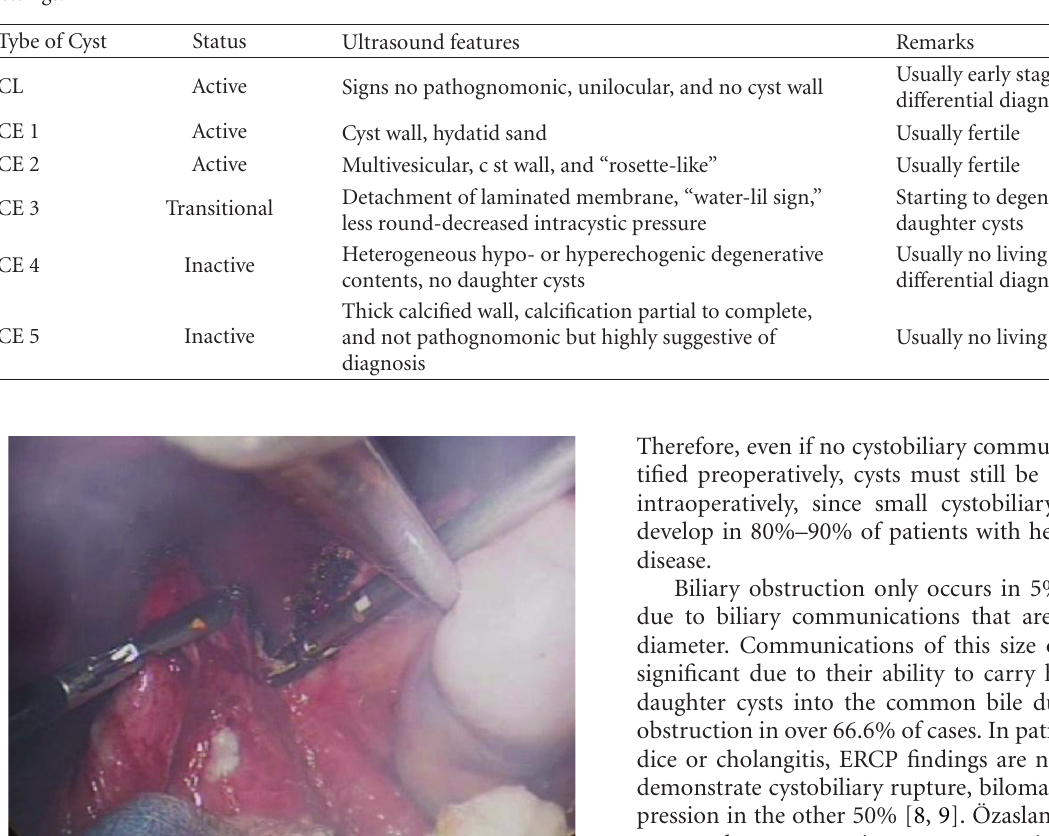
Table 2: International classification of ultrasound images in cystic echinococcosis for application in clinical and field epidemiological settings.